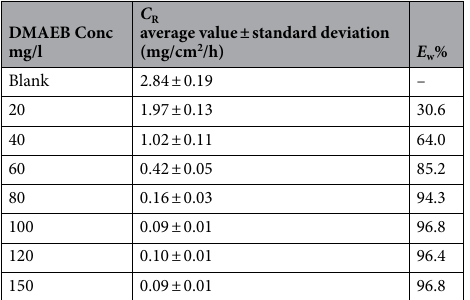
DMAEB Conc mg/l